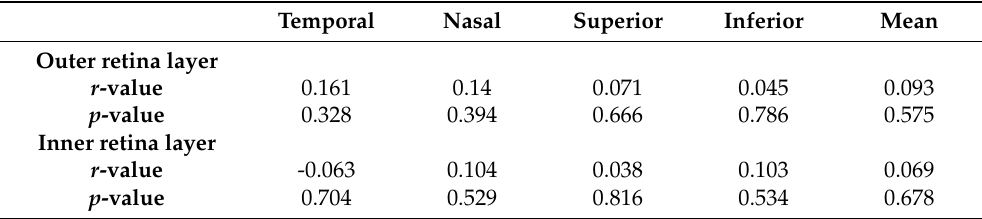
patients with DONFL 6 months after surgery, using Spearman’s correlation